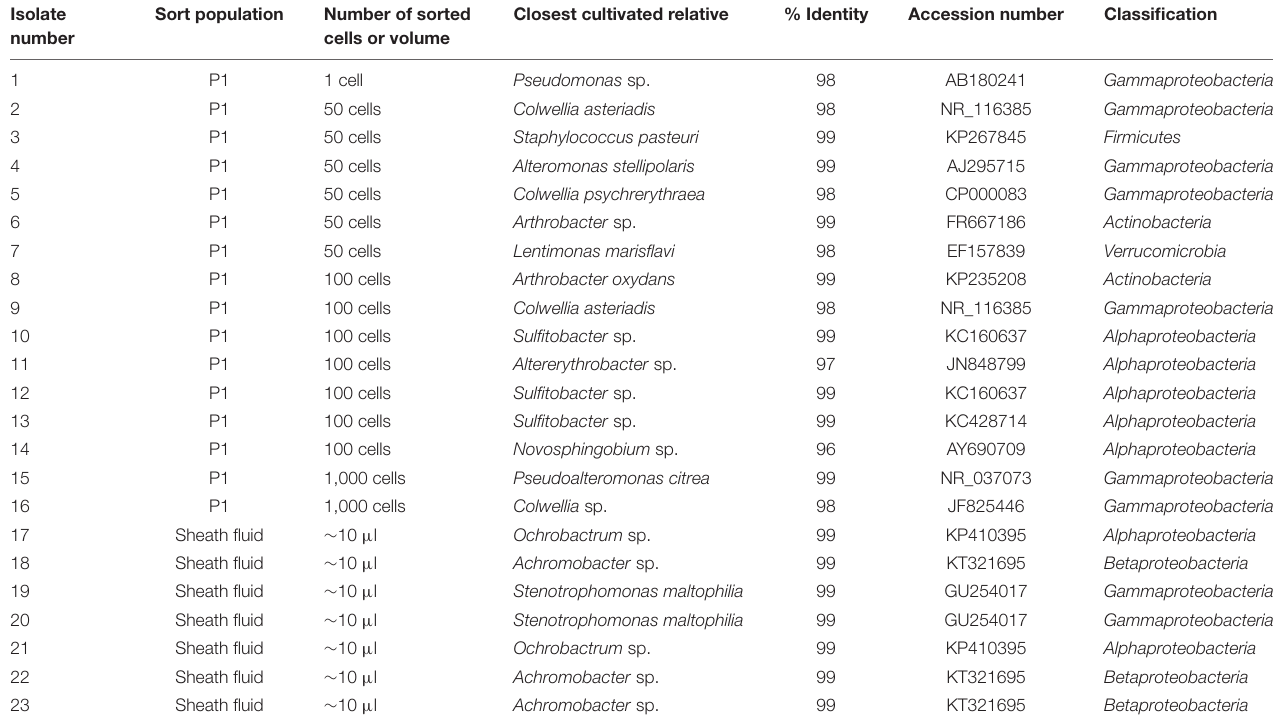
TABLE 2 | List of isolates from this study and their